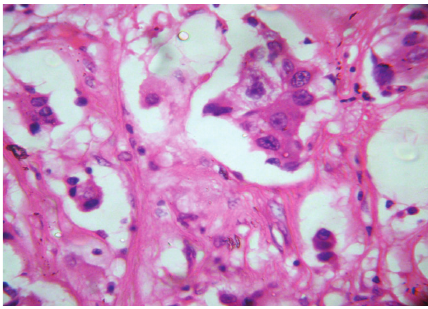
Figure 4: Photomicrograph of a case with pPR (H&E ×